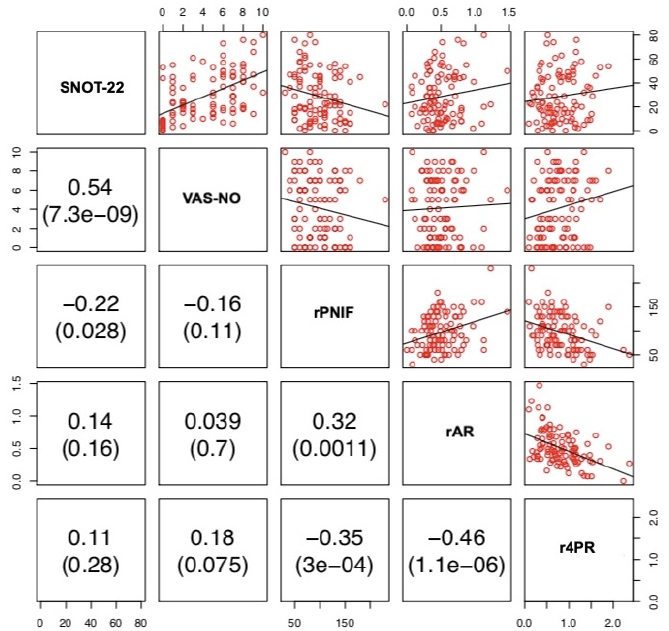
Figure 3. Correlation between SNOT-22, VAS-NO, rPNIF, rAR and r4PR. rPNIF: right Peak Nasal Inspiratory Flow; rAR: right acoustic rhinometry; r4PR: right 4-Phase Rhinomanometry; SNOT-22: Sinonasal Outcome Test-22; VAS-NO: Visual Analogue Scale for Nasal Obstruction.